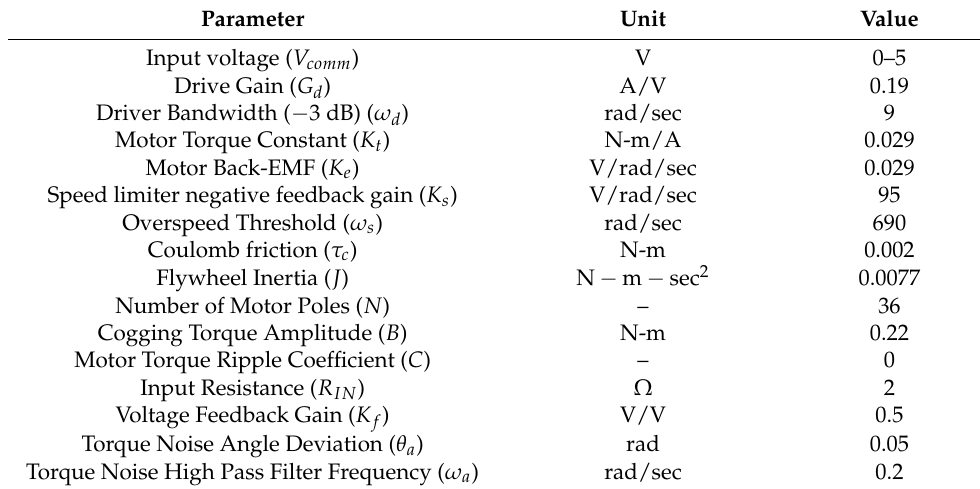
Table 2. RW’s model parameters from the data in